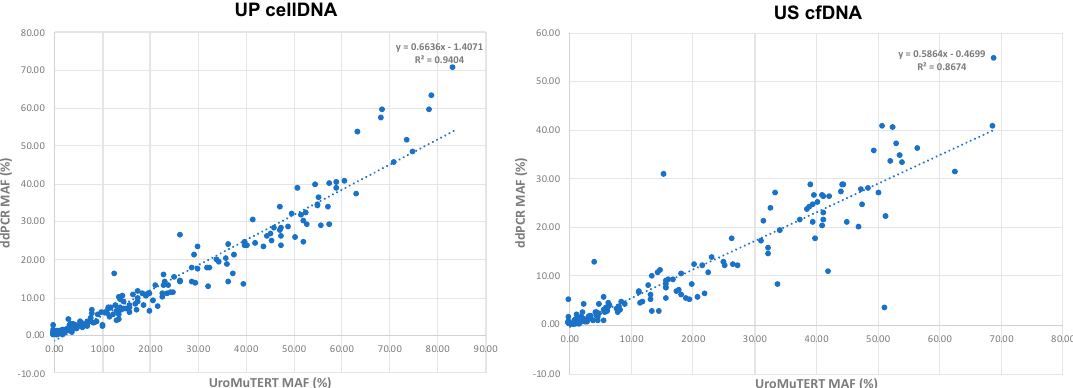
Figure 5. Correlation of TERT promoter Mutant Allelic Fractions (MAFs) between ddPCR and UroMuTERT assays in the two types of urinary DNA samples. Scatter plots of MAFs obtained by ddPCR and UroMuTERT assays run on US cfDNA ( n = 172; left panel) and UP cellDNA ( n = 222; right panel) from patients enrolled in the two case-control studies (DIAGURO and IPO-PORTO) and in the follow-up BC study.